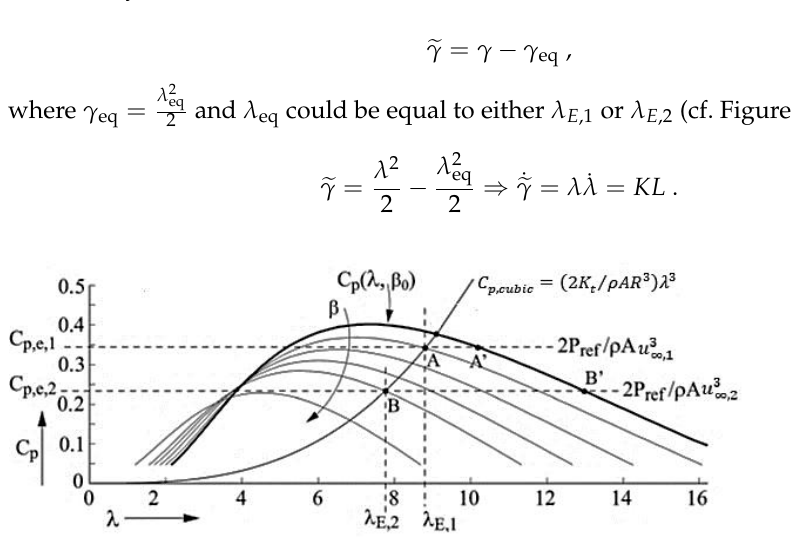
Figure 5. Equilibrium points for a variable pitch angle wind turbine